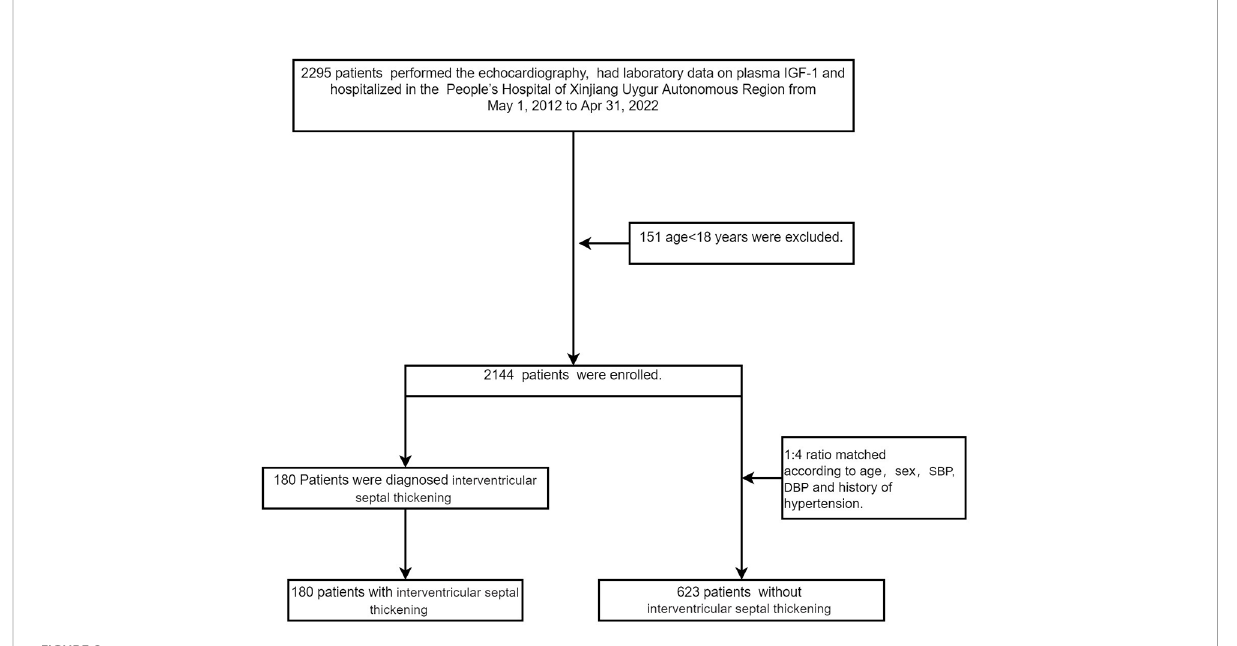
FIGURE 2 Flow chart of patient selection in our study.